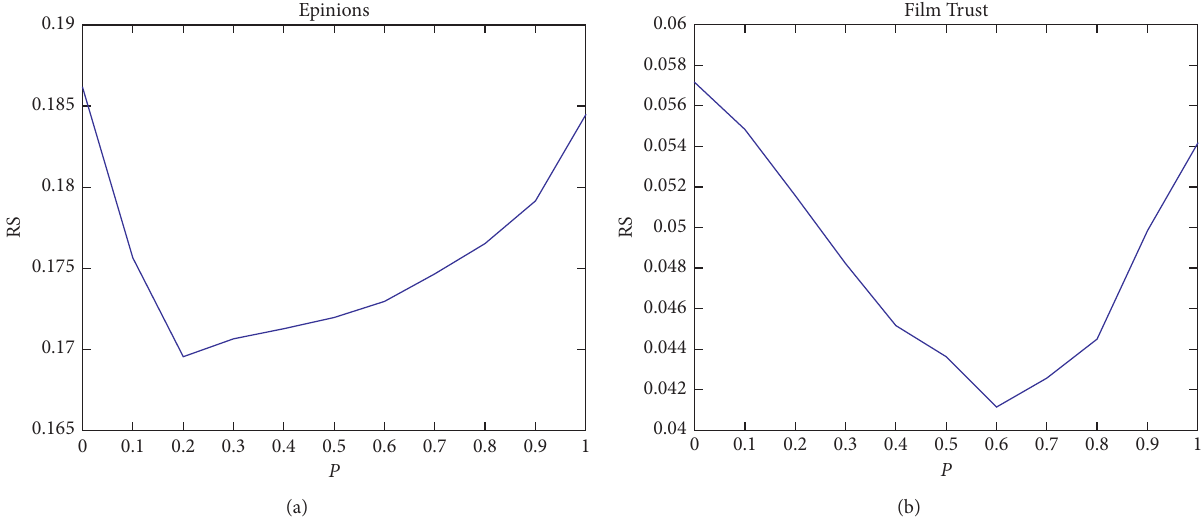
Figure 8: The performance of SMD on small-degree users on the two datasets. (a) Epinions dataset. (b) FilmTrust dataset.